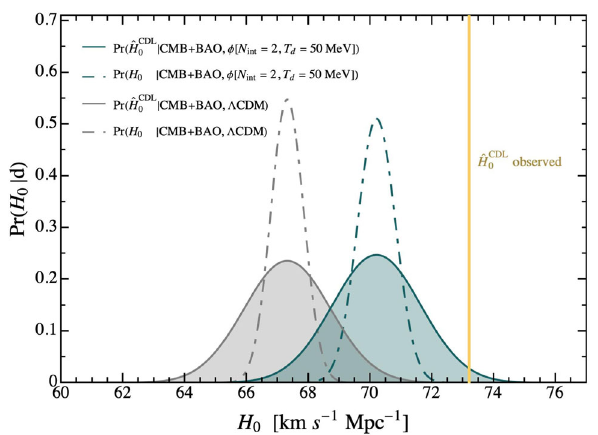
Fig. 7 Probability Predictive Distributions (PPD) (shaded) for the SH 0 ES measurement of H 0 , conditioned on Planck2018+BAO data and assuming either (cid:3) CDM (grey) or the leptogenesis-motivated majoron model with N int = 2 and a decoupling temperature of 50 MeV (green). The posterior on H 0 for each model is shown for comparison with dot- dashed lines, and the central value of the SH 0 ES measurement in shown for comparison in yellow